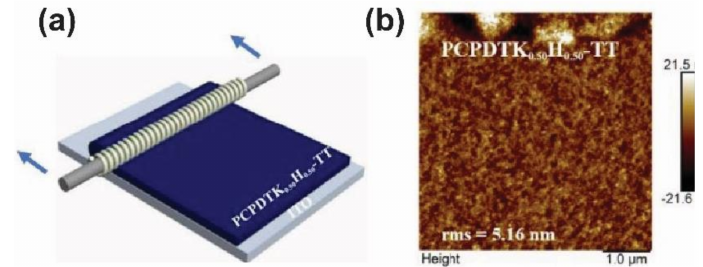
Figure 19. ( a ) Wire-bar coating process and ( b ) AFM image of the PCPDTK0.50H0.50-TT film prepared by the wire-bar coating process. Adapted with permission from [365]. Copyright 2021, American Chemical